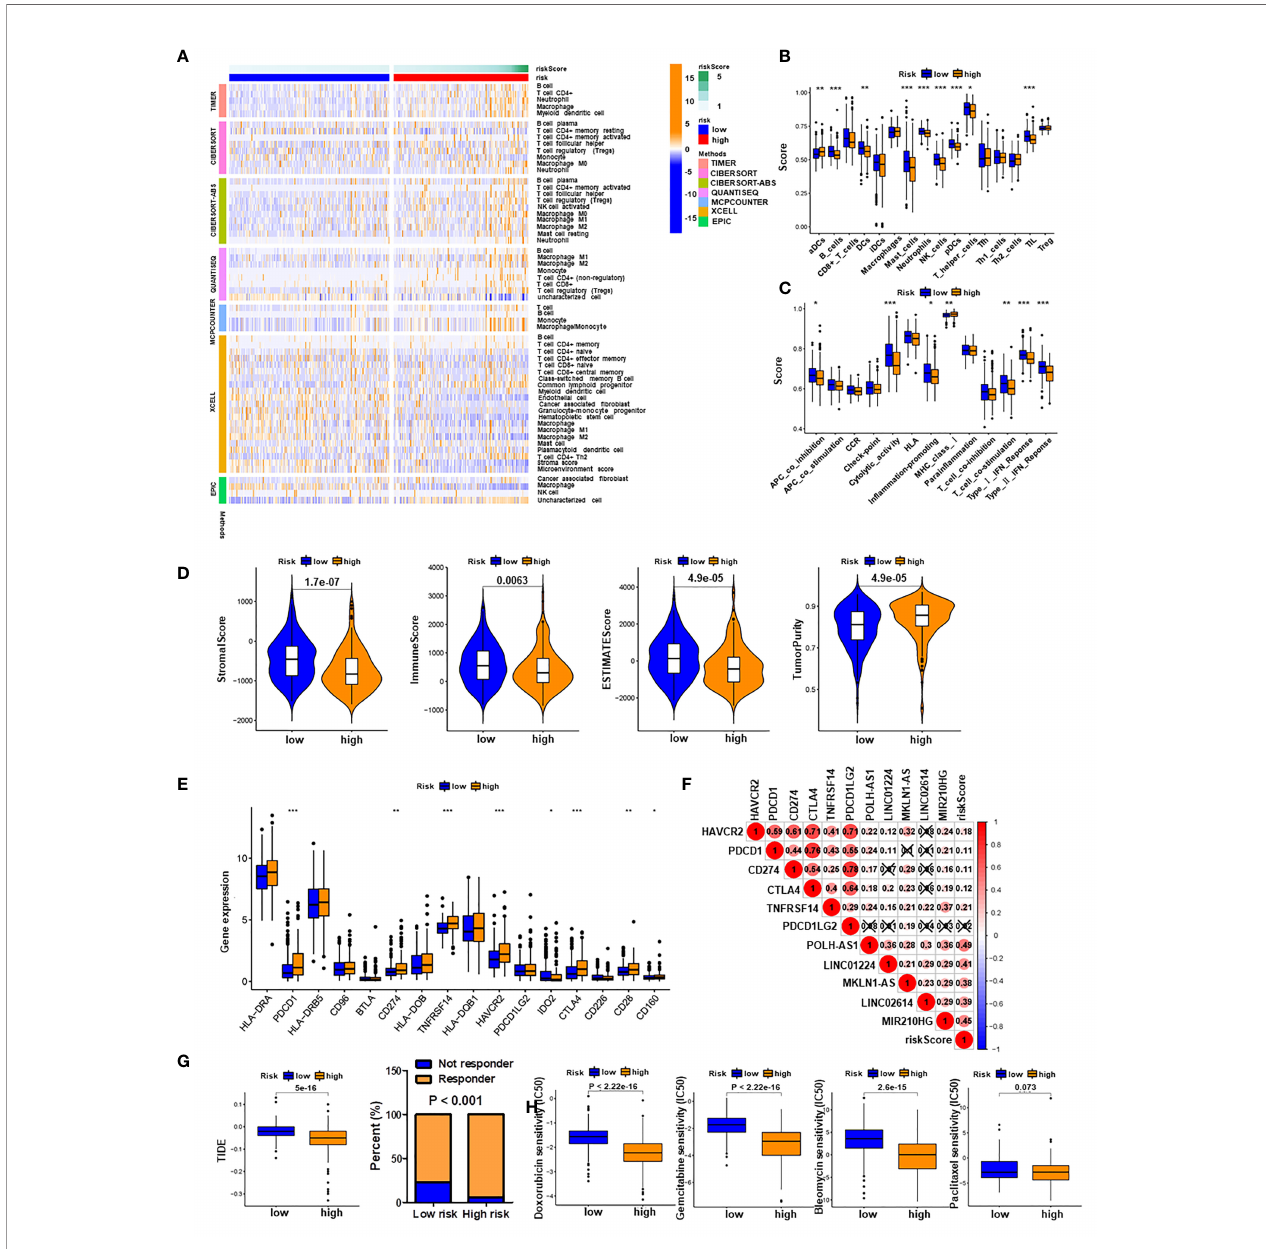
FIGURE 8 | Immune in fi ltration analysis and prediction of immunotherapy and chemotherapy response. (A) Heatmap of all signi fi cantly differential immune responses between high- and low-risk groups based on TIMER, CIBERSORT, CIBERSORT-ABS, QUANTISEQ, MCPCOUNTER, XCELL, and EPIC algorithms. Immune cell scores (B) and immune function scores (C) in high- and low-risk groups based on ssGSEA algorithm. (D) Comparison of stromal scores, immune scores, estimate scores, and tumor purity between HCC patients in high- and low-risk groups. (E) Expression levels of immune checkpoint genes in high- and low-risk groups. (F) Associations of PRlncSig score with pyroptosis-related lncRNAs and immune checkpoint genes. (G) Comparison of TIDE prediction scores (left) and response to immunotherapy (right) between the high- and low-risk groups in the TCGA_LIHC dataset. (H) Assessment of sensitivity to several chemotherapeutics (doxorubicin, gemcitabine, bleomycin, and paclitaxel in the high- and low-risk groups. * P < 0.05, ** P < 0.01, *** P <